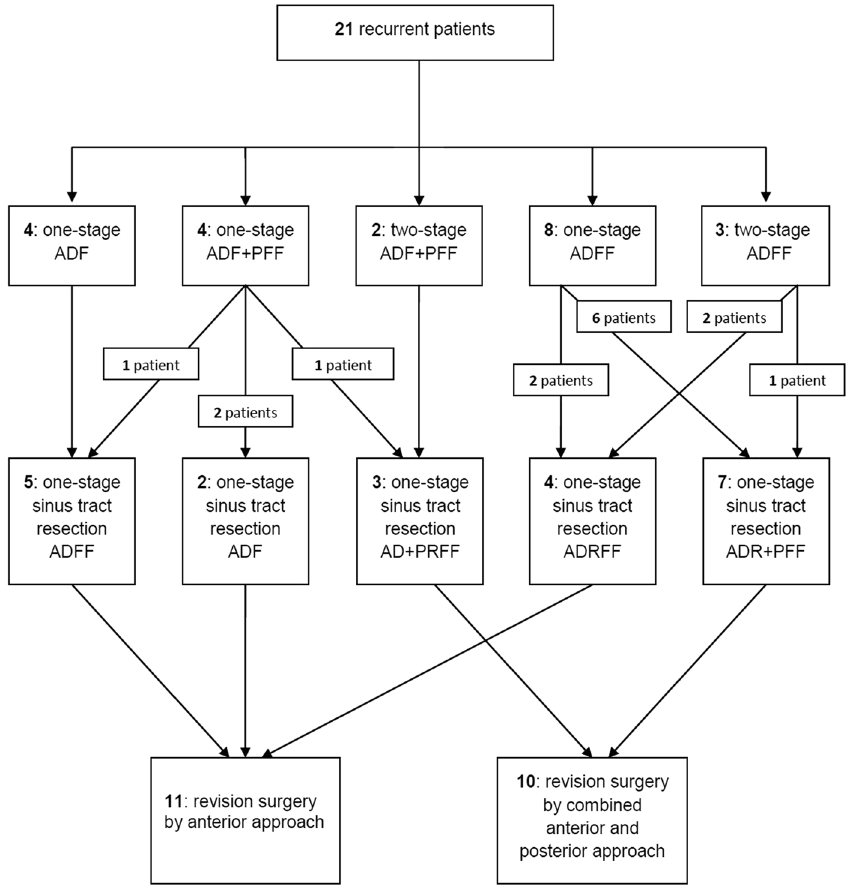
Figure 1. A schematic drawing of the elements of the revision surgery strategy. (AD: anterior debridement; ADF: anterior debridement and fusion; ADFF: anterior debridement, fusion and fixation; ADR: anterior debridement and internal fixation removal; ADRFF: anterior debridement, internal fixation removal, fusion and fixation; PFF: posterior fusion and fixation; PRFF: posterior internal fixation removal, fusion and